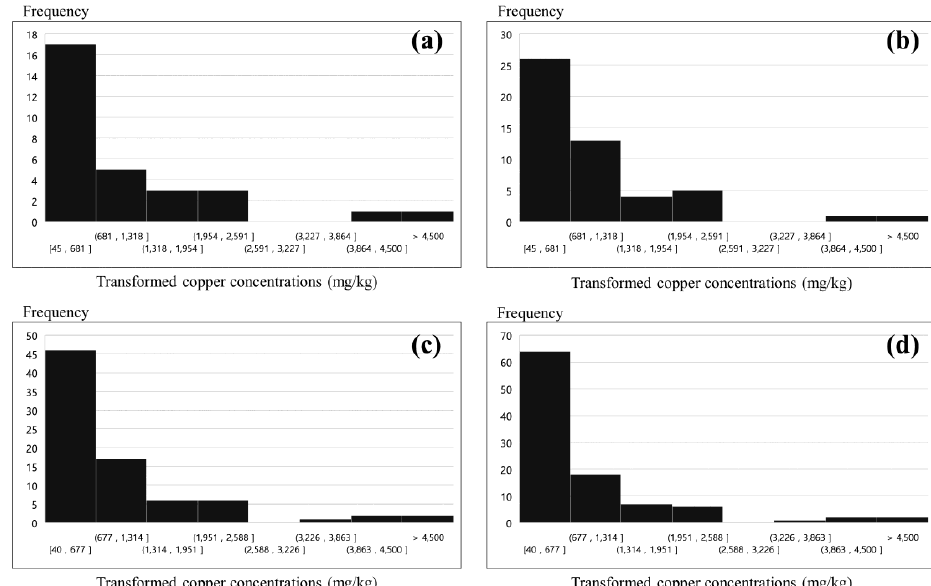
Figure 5. Copper-concentration histograms for transformed PXRF data: ( a ) 30 (first phase); ( b ) 50 (second phase); ( c ) 80 (third phase); and ( d ) 100 sampling points (fourth phase). Table 2. Descriptive statistics of the transformed copper concentration and Gi* z -score results according to the four-phase procedure.